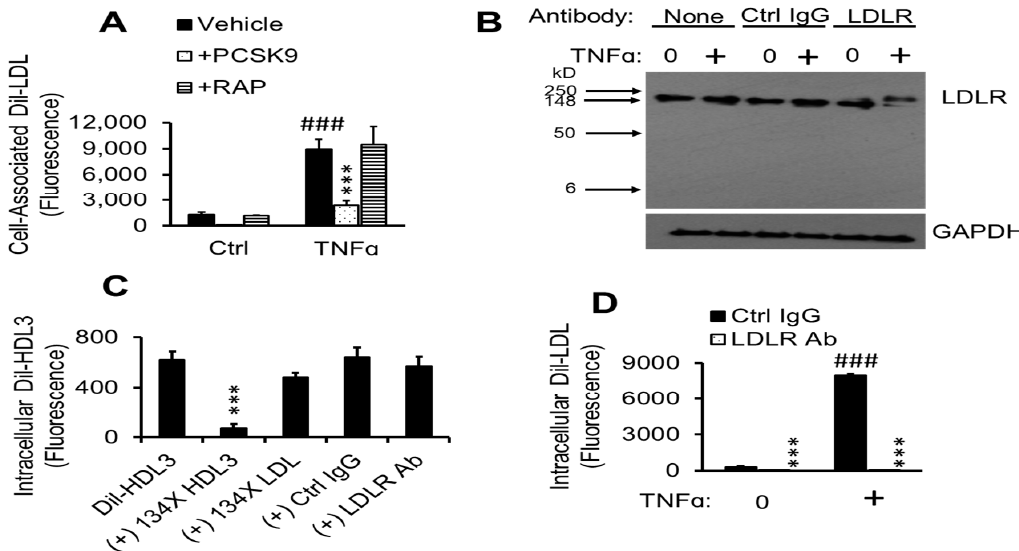
Figure 7. TNF ɑ -induced Dil-LDL accumulation is blocked by specific LDLR antibody. ( A ) pHAECs in serum medium were pre-treated with 0 (Ctrl) or 100 ng/mL TNF ɑ for 24 h. Afterwards, the cells were cultured in the presence of vehicle, 12.5 µg/mL human PCSK9 (ApoER, LDLR, LRP, and VLDLR inhibitors), or 21 µg/mL human RAP (ApoER2, LRP, and VLDLR inhibitors) in serum-free medium for 1 h. Lastly, 8 µg/mL Dil-LDL was added, followed by 4 h incubation. n = 3. ###, ***, p < 0.001 vs. Ctrl vehicle and TNF ɑ vehicle, respectively. ( B ), Cells were cultured in serum medium ± 100 ng/mL